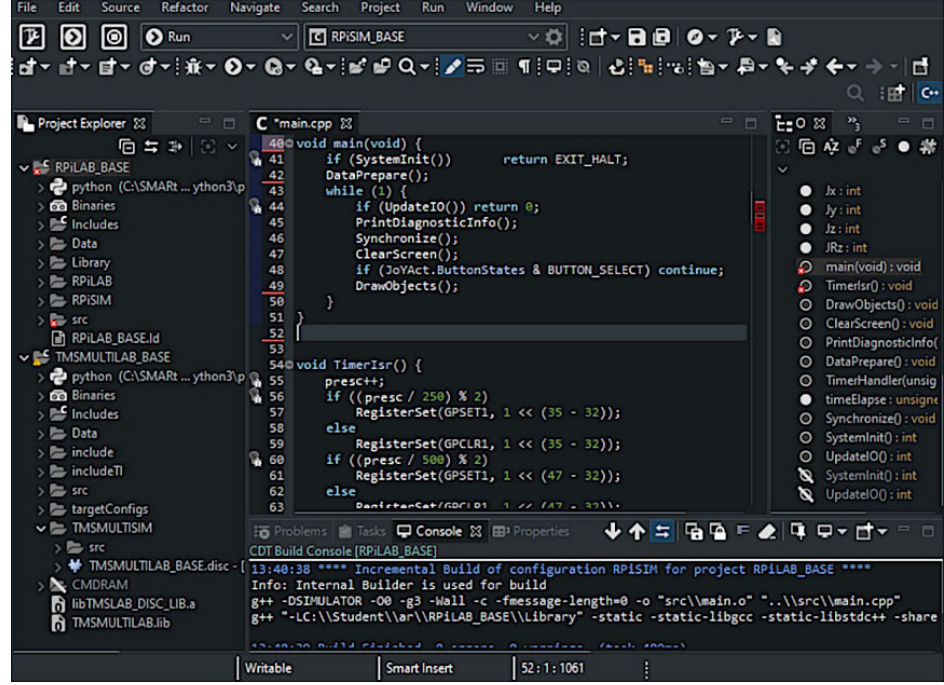
Figure 4. The Eclipse CDT IDE [46] used for programming real RPILAB and virtual simulators of RPILAB and TMSLAB.